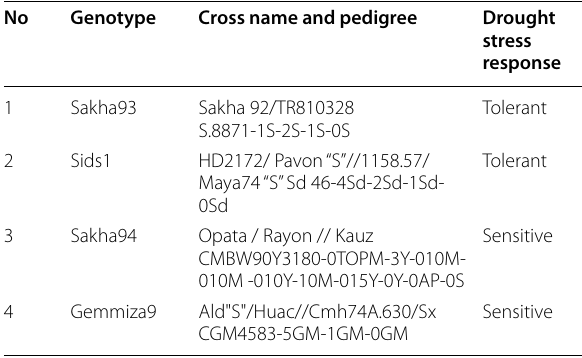
Table 1 Names, pedigree, and drought stress response of the parental genotypes used in the study according to previous findings from the maize breeding program in Egypt